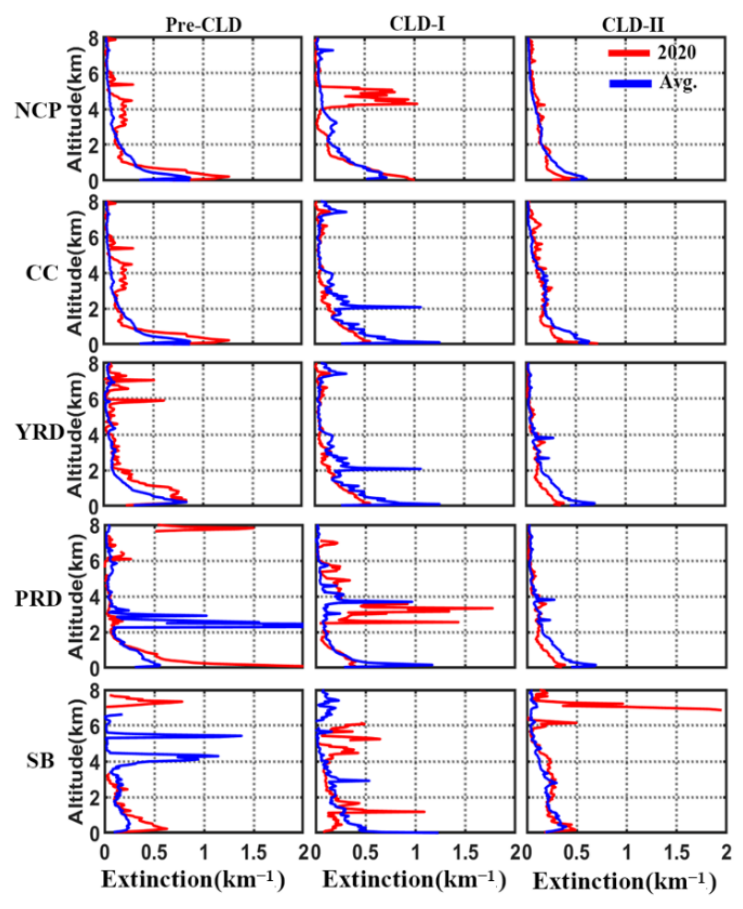
Figure 8. Profiles of AEC for five studies areas from CALIPSO retrievals in the Pre-CLD, CLD-I, and CLD-II periods. The red curve represents the 2020 data, and the blue curve represents the 2017–2019 data average.